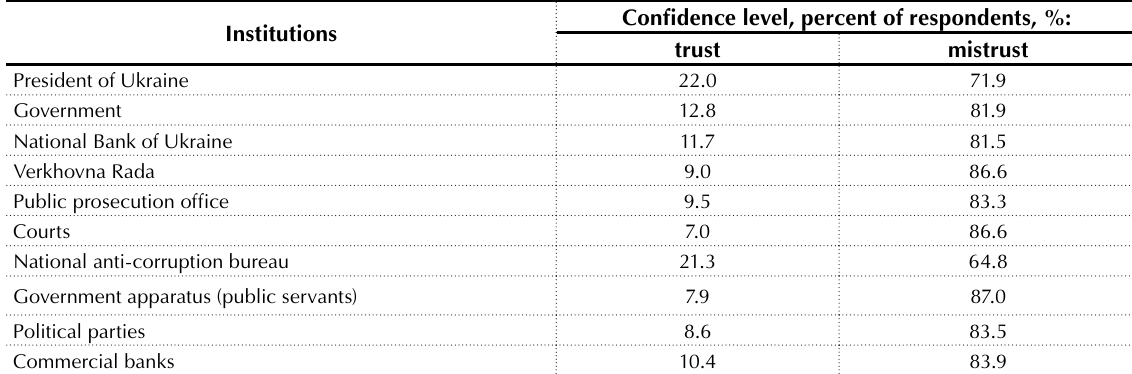
Table 6. Ukrainian population’s confidence in the political and economic